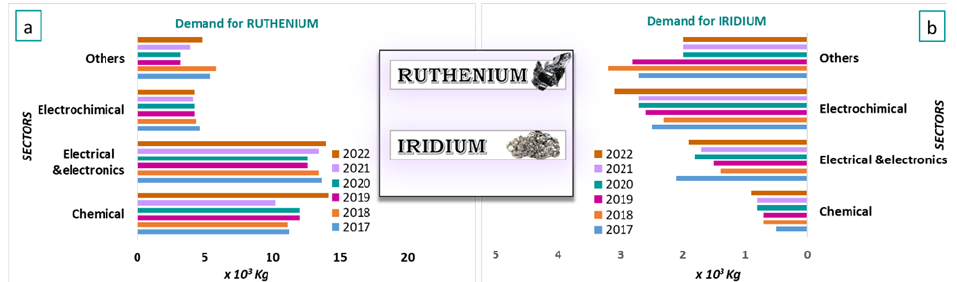
Figure 7. ( a ) Ruthenium demand by sectors from 2017 – 2022; ( b ) Iridium demand by sectors from 2017 (according to the data from [49]).